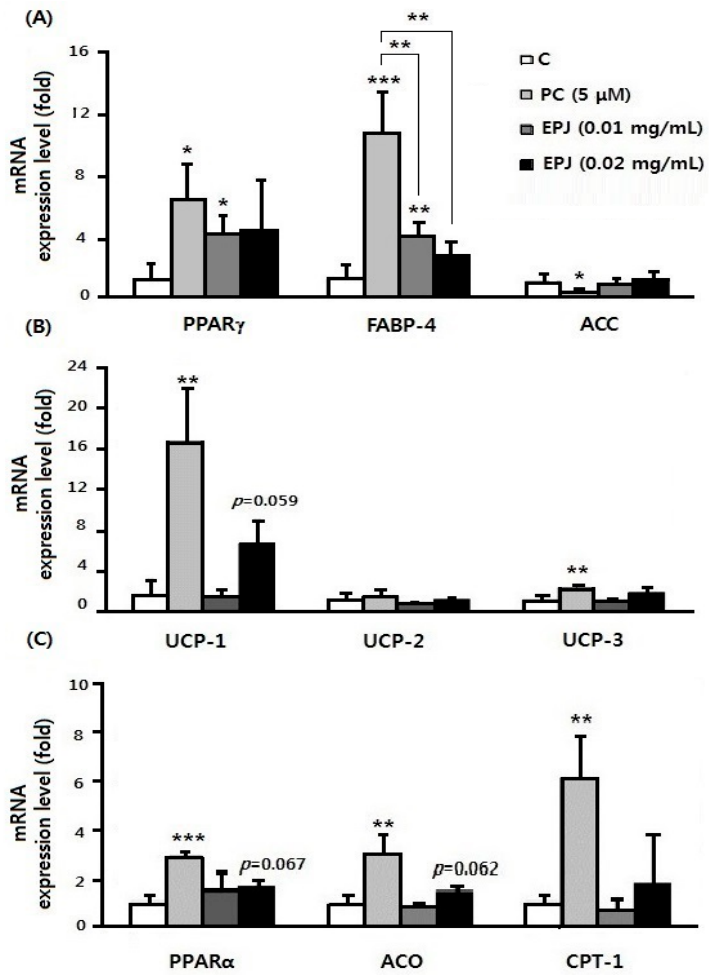
Figure 5. In 3T3-L1 adipocytes, qRT-PCR was performed to detect the expression of PPAR γ , FABP-4, Figure 5. In 3T3 ‐ L1 adipocytes, qRT ‐ PCR was performed to detect the expression of PPAR γ , FABP ‐ 4, ACC, UCP-1, UCP-2, UCP-3, ACO, CPT-1, and PPAR α ( A – C ) using 36B4 as the endogenous ACC, UCP ‐ 1, UCP ‐ 2, UCP ‐ 3, ACO, CPT ‐ 1, and PPAR α ( A ~ C ) using 36B4 as the endogenous control.